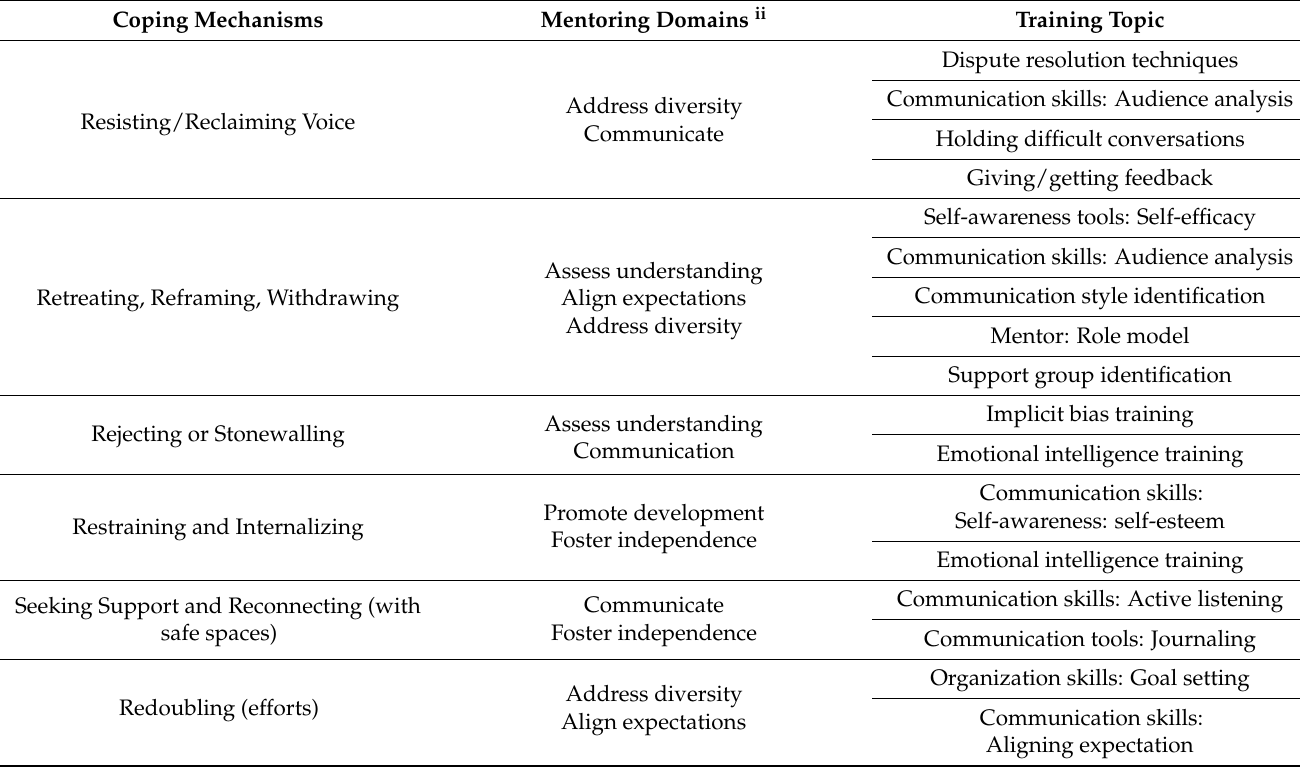
Table 2. Mentor training session topics to support microaggression coping